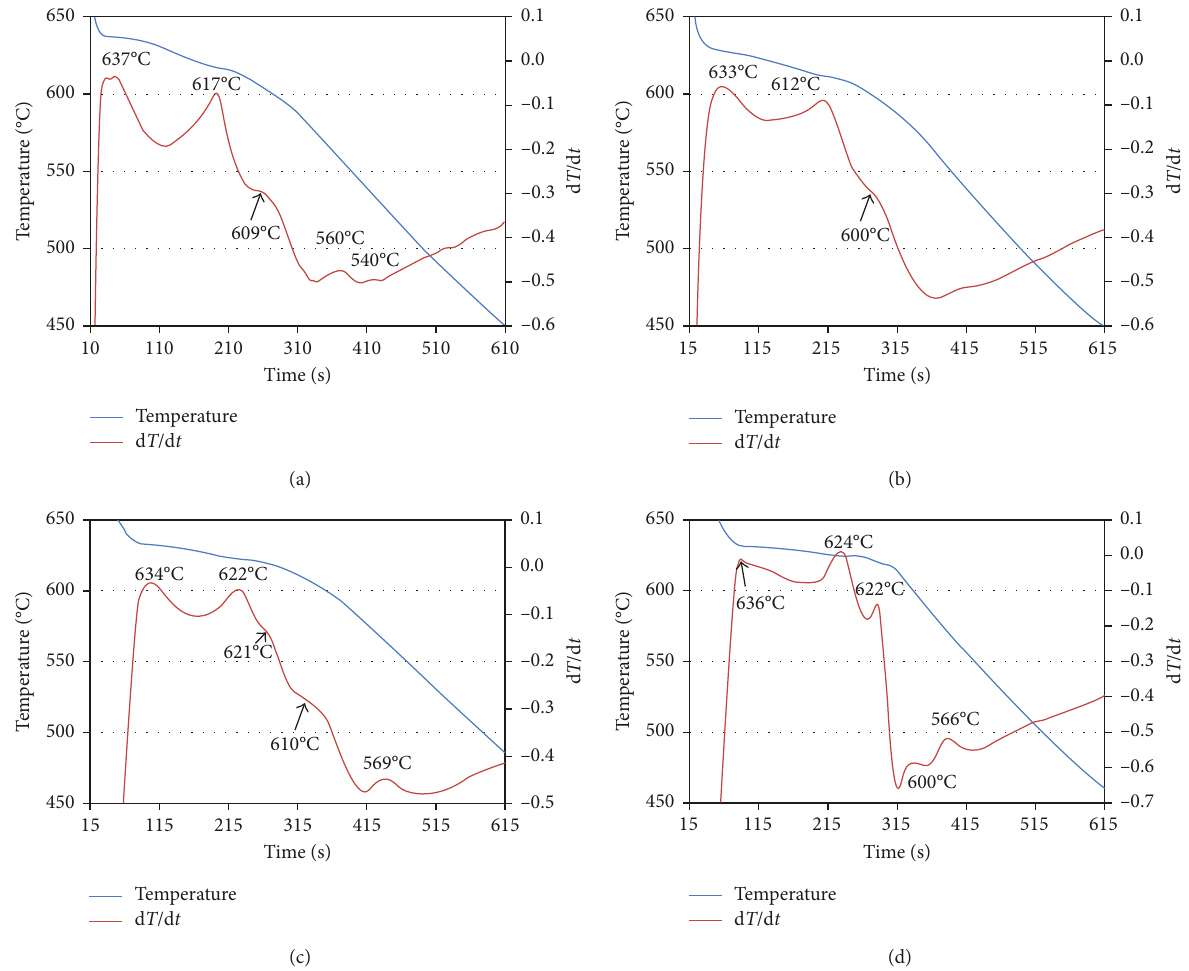
Figure 3: Temperature-time curves and their first derivatives obtained from the B0 alloy series: (a) B0+Ce; (b) B0+Ce +Ti; (c) B0+La; (d) B0+La +Ti.